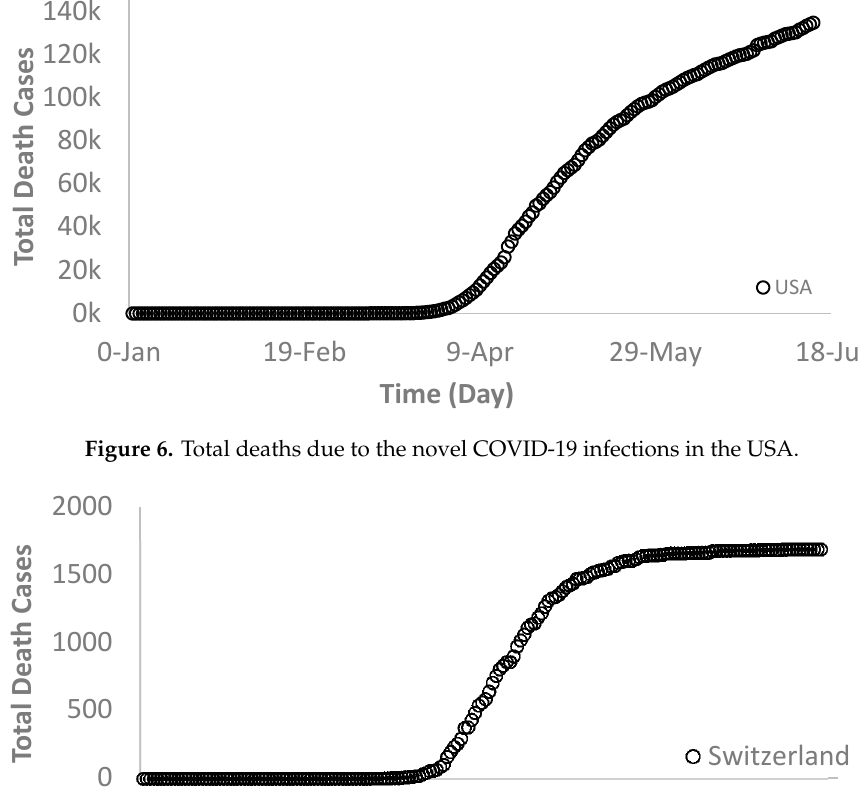
Figure 5. The world deaths due to the novel COVID-19 infections.